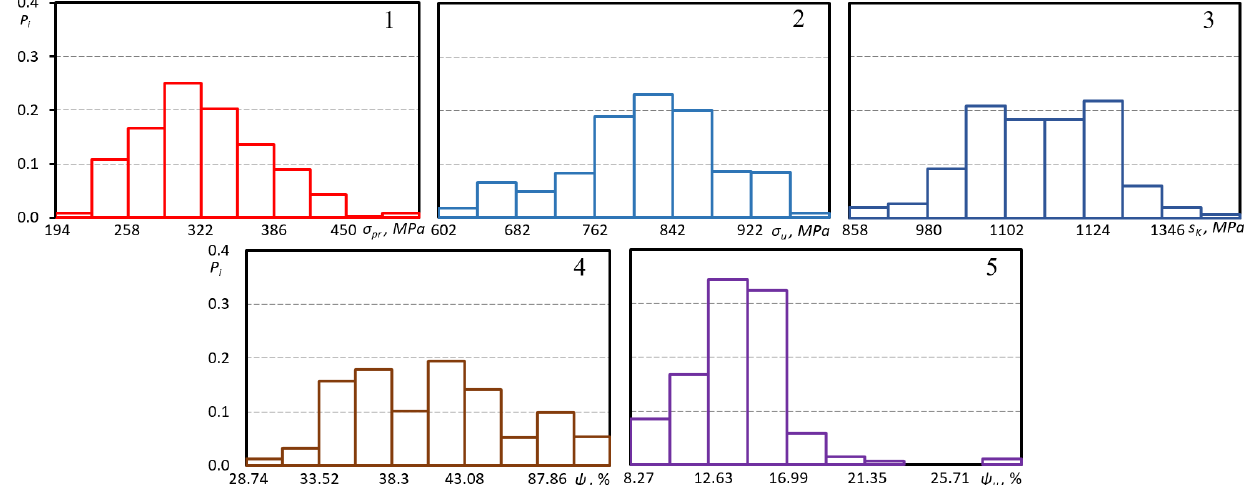
Figure 3. Histograms of mechanical properties of steel C45 (1 — σ pr ; 2 — σ u ; 3 — S k ; 4 — ψ ; and 5 — ψ u ).